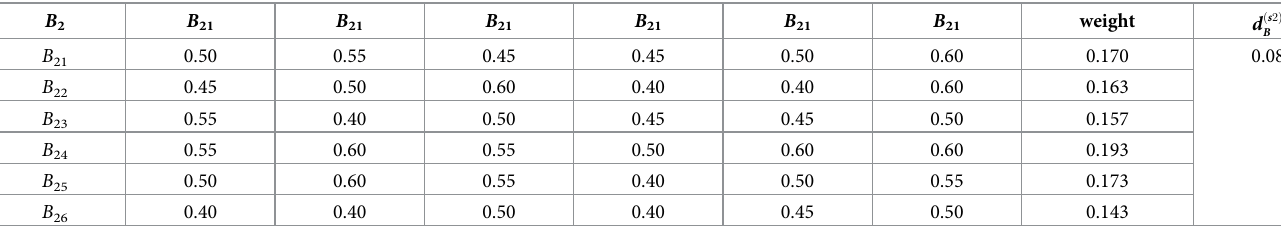
of expert s 2. B